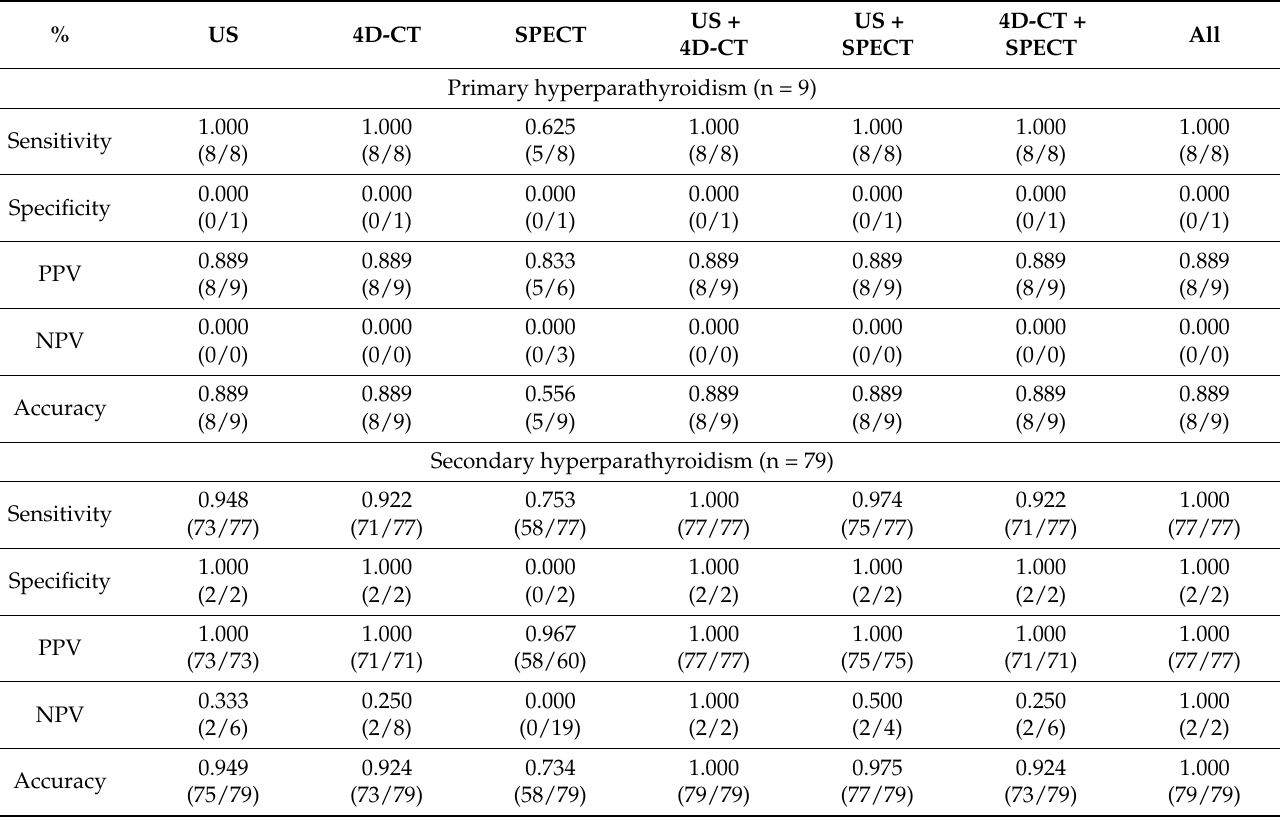
Table 4. Diagnostic Accuracy of Imaging Modalities Analyzed by Lesion (Primary or Secondary